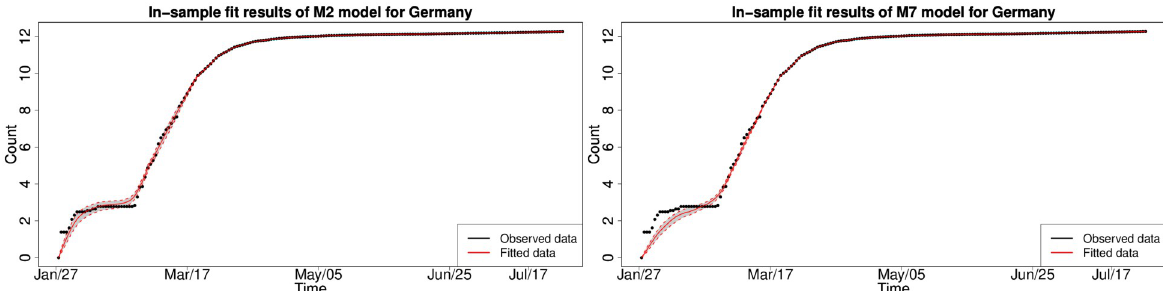
Fig 7. In-sample fit results for Germany for the period January 2020—August 2020. In-sample fitted plot (y-axis in log scale) for Germany by Model 2 (baseline, left) and Model 7 (best, right) (January 2020—August